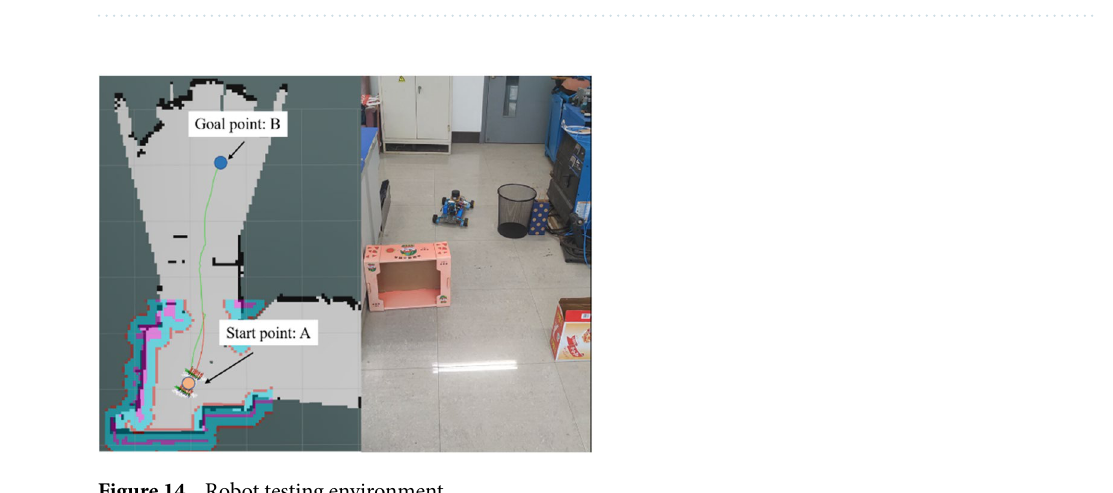
Figure 13. Robot speed output curves of the traditional TEB algorithm and the proposed TEB algorithm.